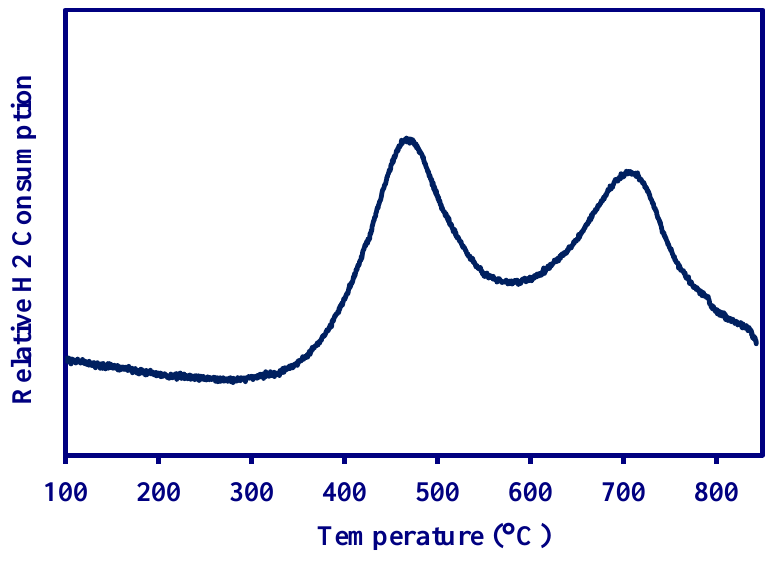
Figure 2. H -TPR profile of MNS 2